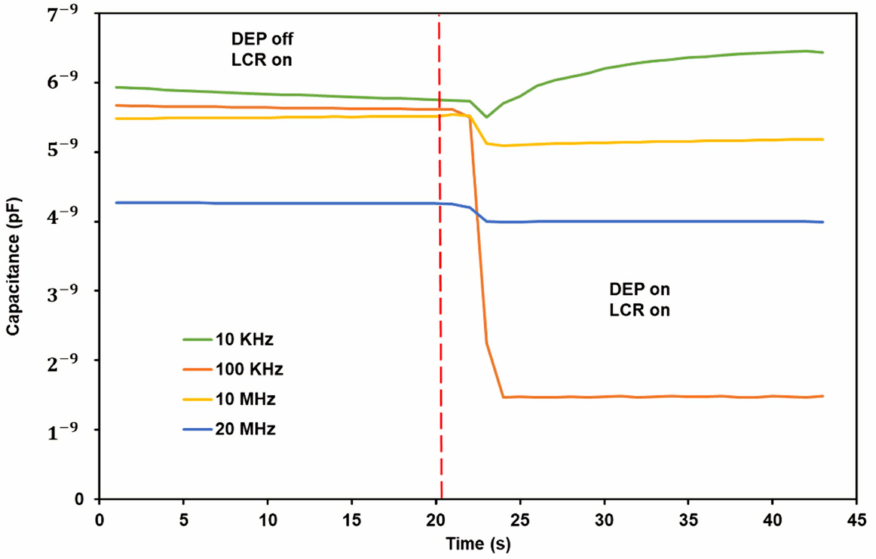
Figure 11. Capacitance measurement of 0.05 µ m polystyrene beads and deionized water as the suspending